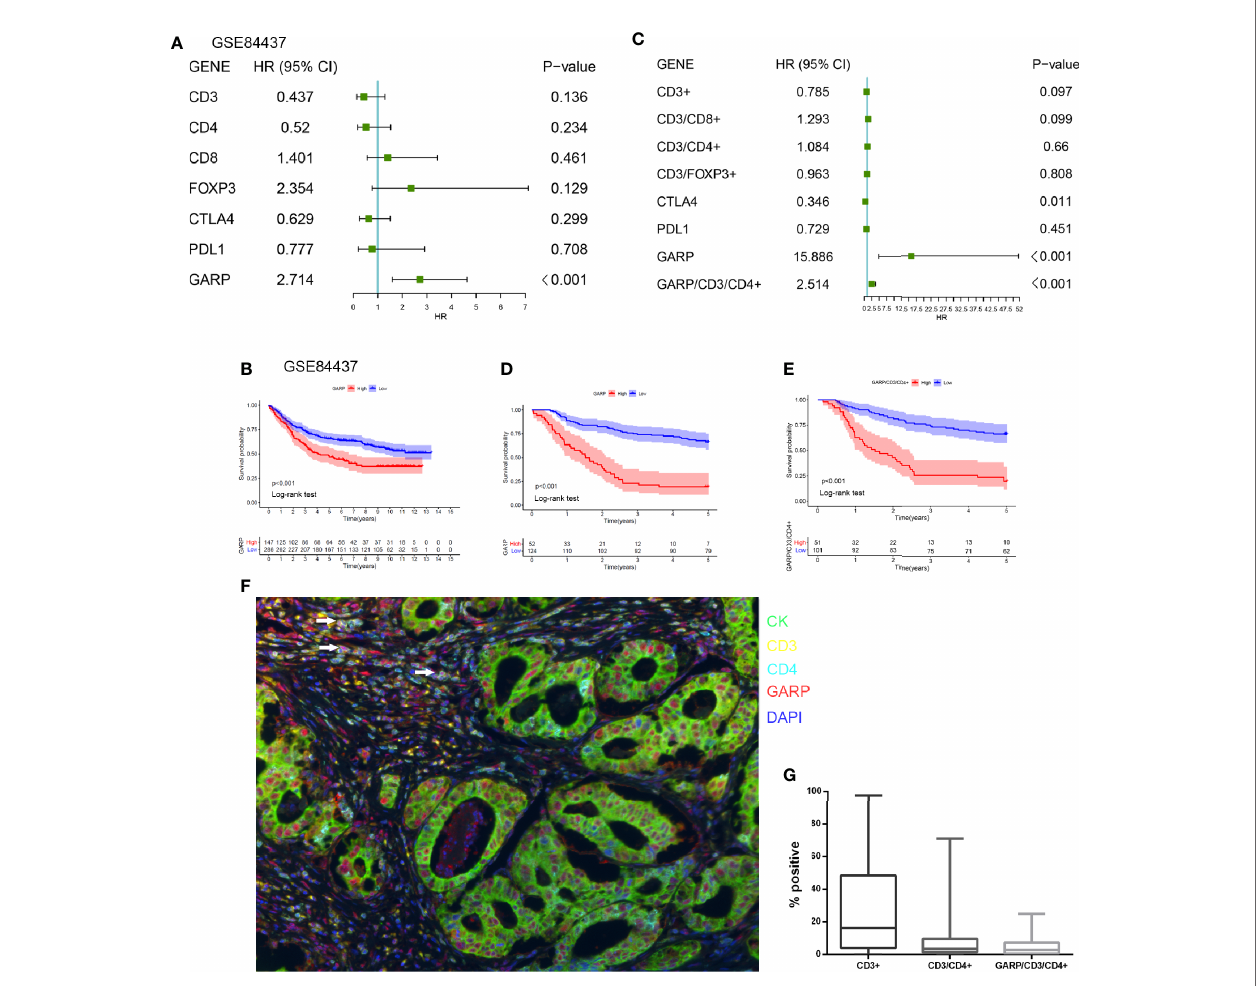
FIGURE 4 | (A) A forest plot visualizing the impact of the immune microenvironment (TME)-associated signatures and GARP on overall survival (OS) in the GSE84437, as evaluated using Cox univariate tests. (B) Kaplan – Meier curve for the high and low expression groups in the GSE84437. (C) A forest plot visualizing the impact of the immune microenvironment (TME)-associated signatures and GARP on overall survival (OS) in our cohort, as evaluated using Cox univariate tests. (D) Kaplan – Meier curve for the high and low expression groups in our cohort. (E) Kaplan-Meier plot visualizing survival associations of GARP+CD4+ T cell. The optimal cutoff point was obtained from X-tile 3.6.1 software. (F) Representative fl uorescence-based multiplex immunohistochemistry images of the rate of positivity for GARP+CD4+ T cell in tissue microarray sections. (G) A plot shows the rate of positivity for CD3+ T cell, CD4+ T cell, and GARP+ CD4+ T cell. White arrows in the picture that point to the GARP+CD4+